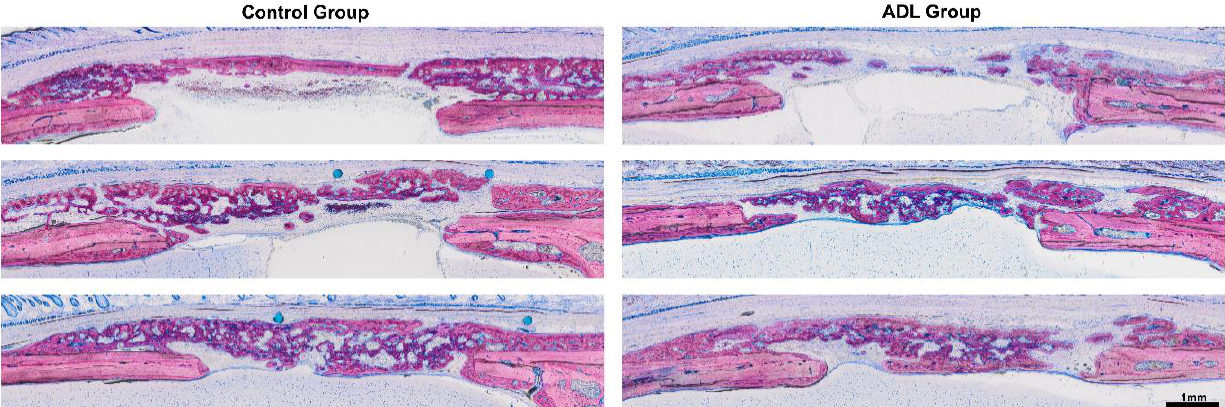
Figure 3. Histological overview of the defect anatomy after four weeks of healing. Rat calvaria defects were treated with native collagen membranes soaked either in serum-free medium, or in acid dentin lysate (ADL). Histological pictures representing the samples with minimum (upper images), median (middle images) and maximum (lower images) bone area based on quantitative analysis. The local host calvaria bone demarcates the defect borders and appears in light purple. The newly formed bone is stained in dark purple. Undecalcified thin ground sections stained with Levai-Laczko.